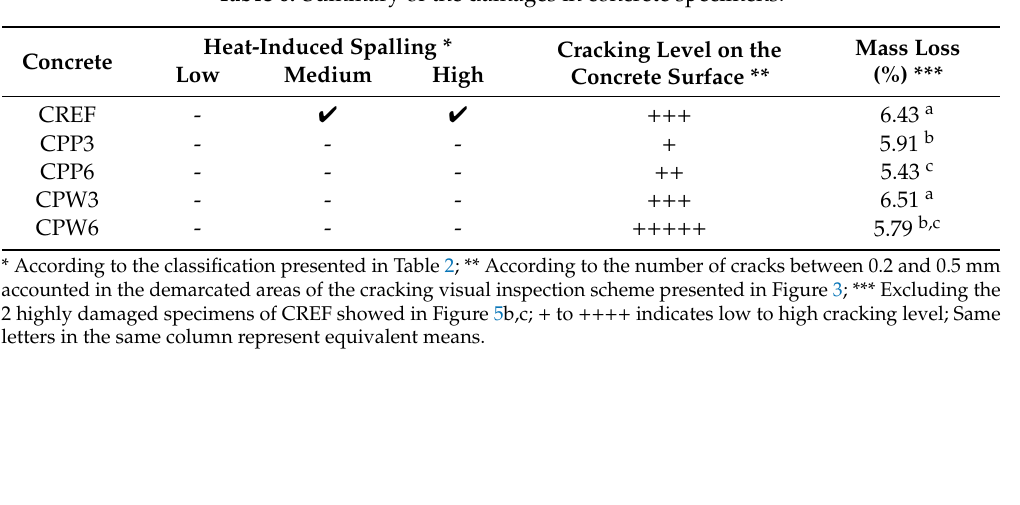
Table 6. Summary of the damages in concrete